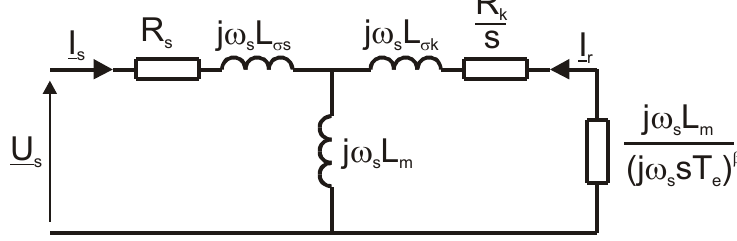
Figure 13. Steady-state solid-rotor induction motor equivalent circuit.